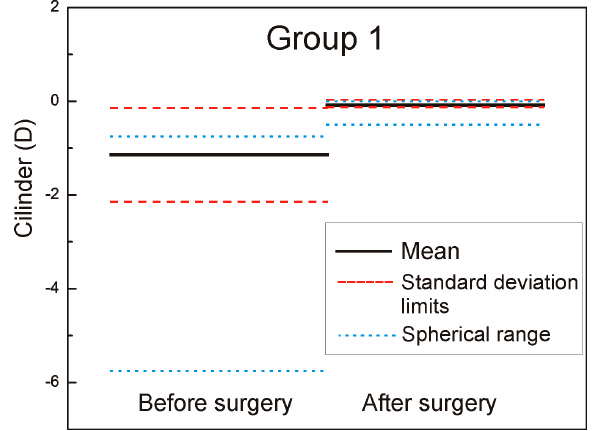
Figure 3. Mean cylinder pre- and postoperative Group 1.